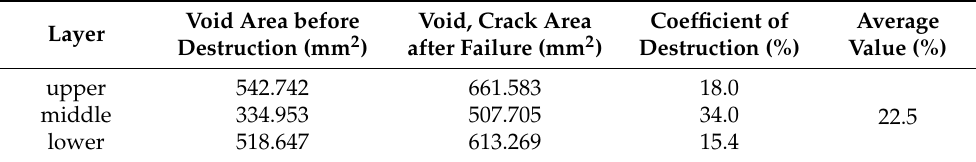
Table 9. Failure coefficient of upper, middle, and lower layers before and after uniaxial